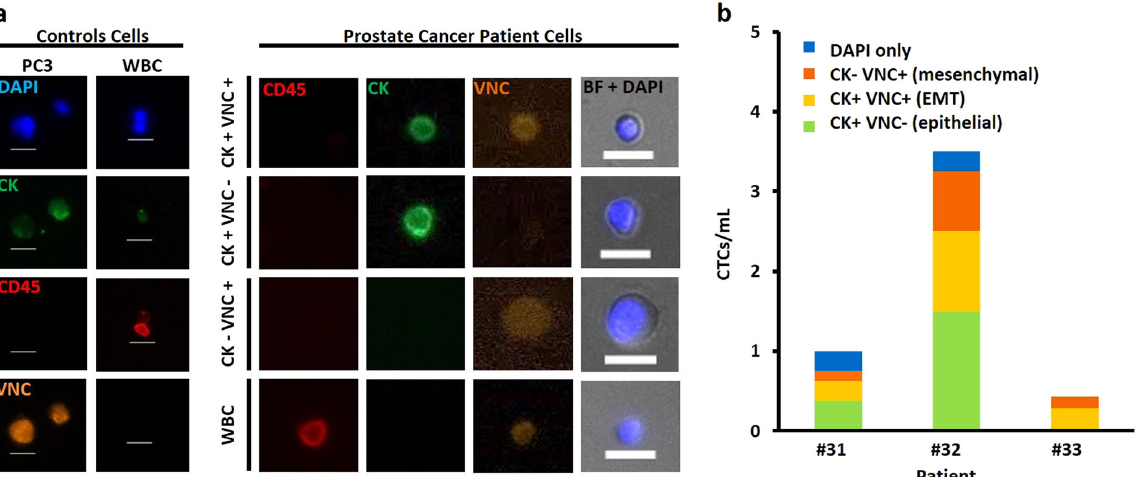
Fig. 5 Staining with markers such as VNC identi fi es cells (CK negative) that may have undergone EMT. a Staining was optimized with PC3 prostate cell lines and WBCs as positive and negative controls, respectively, and applied to three PC patient samples. Different cell